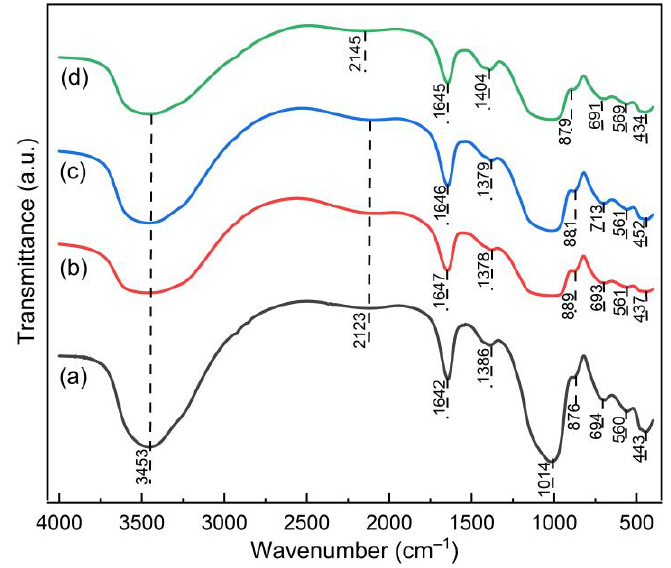
Figure 8. FTIR spectrum of pervaporation membranes shows the vibration bands of the functional groups formed in the network of ( a ) geopolymer; ( b ) Geo–TiO 2 (3), ( c ) Geo–rGO–TiO 2 (0.5, 3),